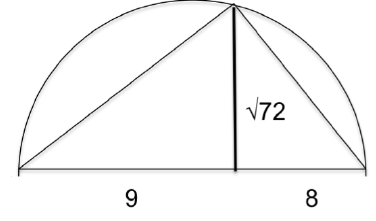
Fig. 1. Proposition 13 of book VI of